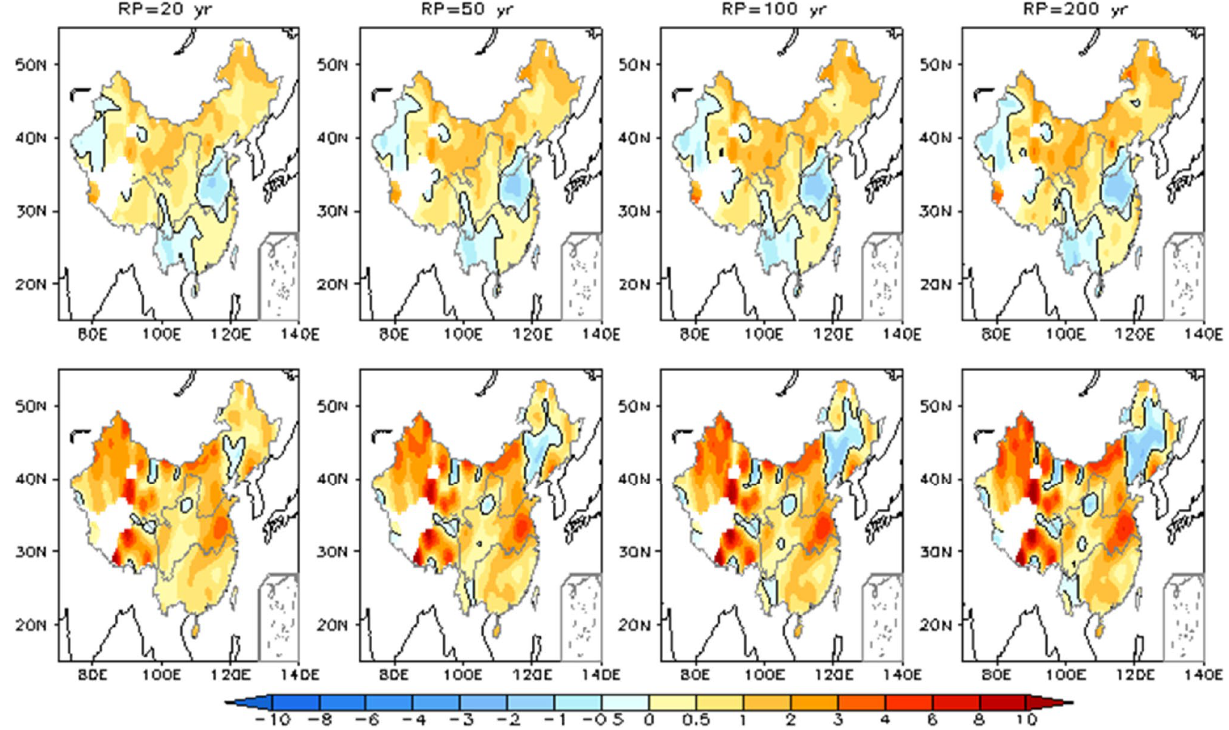
Fig. 5 Spatial difference distributions of HTx (Top panel) and LTn (Bottom Panel) between P2 and P1, respectively, corresponding to RP of 20, 50,100 and 200 years derived from